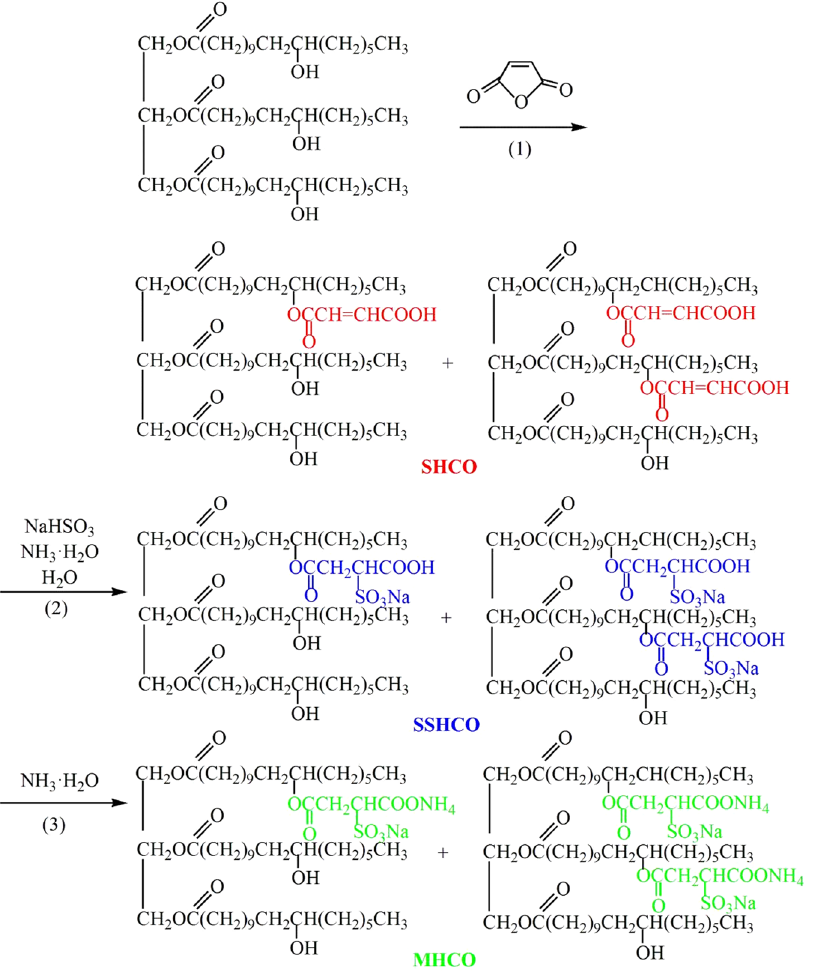
Figure 2. Reaction formula of the preparation of MHCO/GPTMS-ZnO composites.